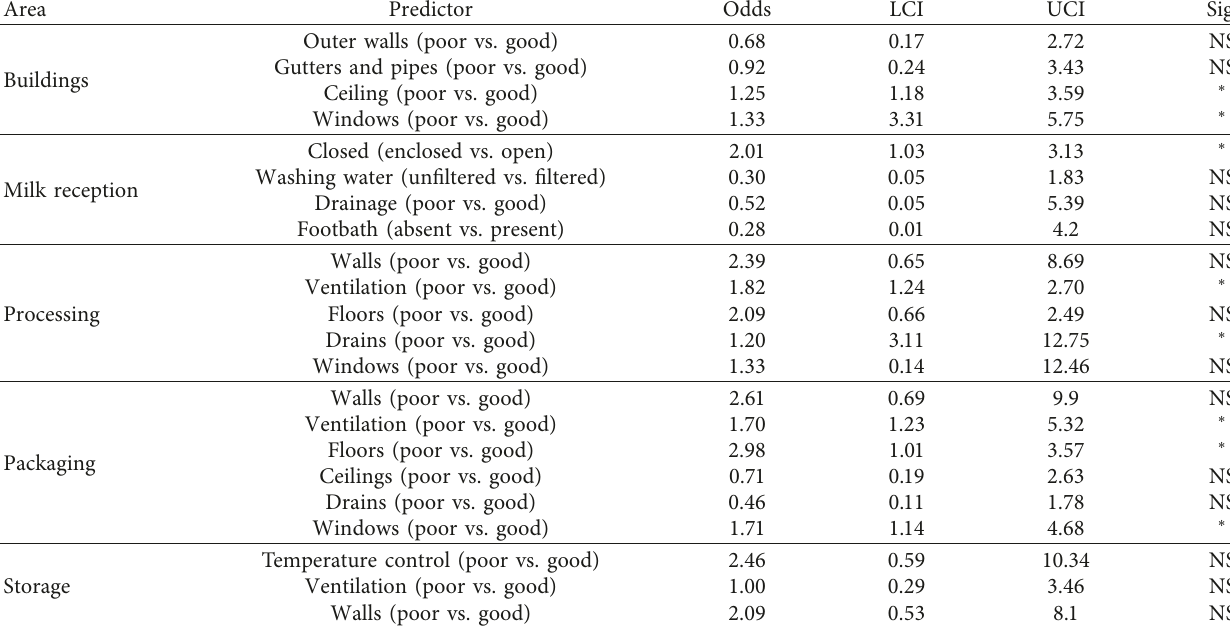
Table 4: Odds ratio estimate and lower (LCI) and upper confidence interval (UCI) of cultured buttermilk from processors with features which are not in adequate conditions having coliforms.